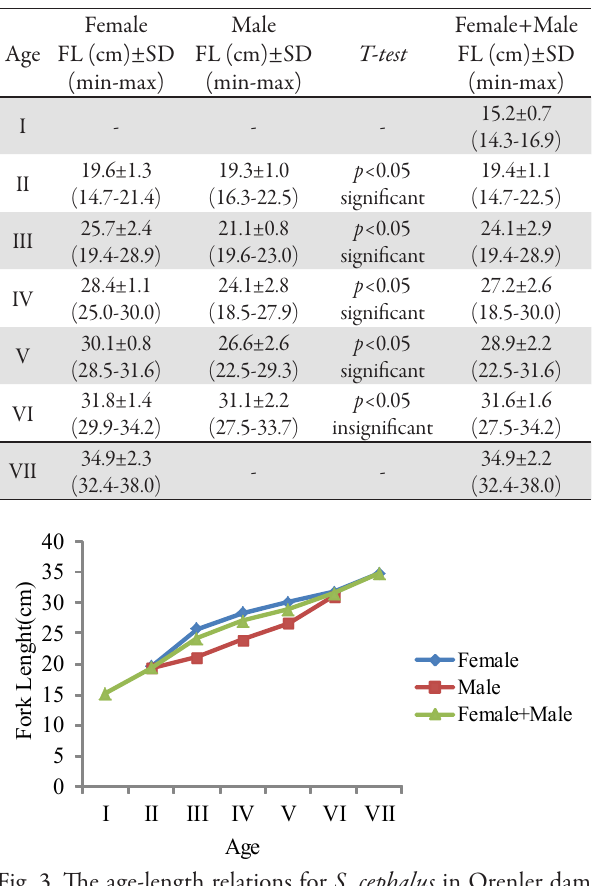
Fig. 3. The age-length relations for S. cephalus in Orenler dam Tab. 3. The weight statistics for age and gender of S. cephalus in Orenler dam lake